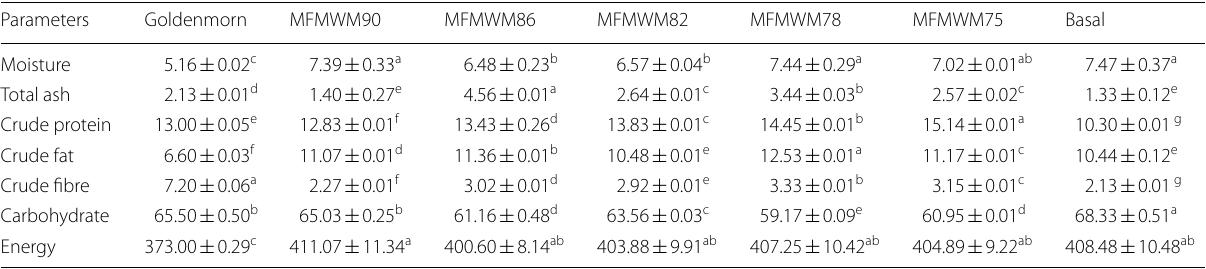
Table 2 Proximate composition (g/100 g) and energy value (Kcal/100 g) of malted finger millet-watermelon seed flour blends